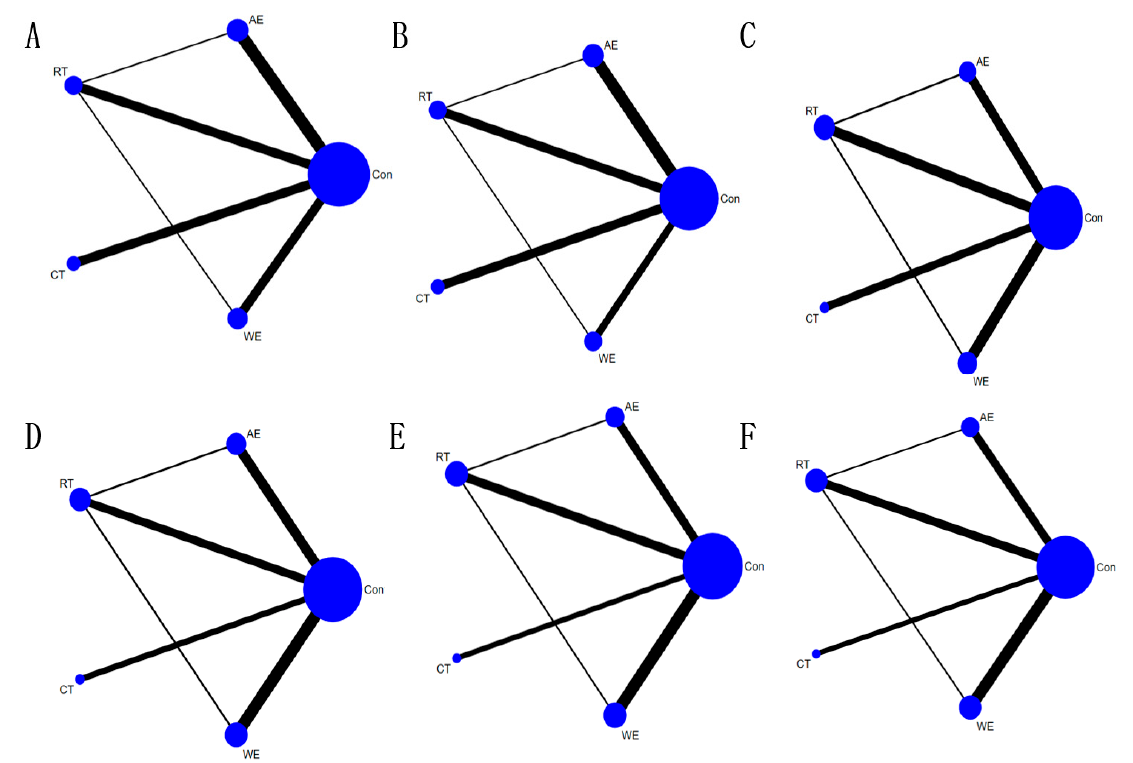
Figure 2. Evidence network diagram of network meta-analysis comparisons. Each node represents one exercise type. The lines between the dots indicate a direct comparison between the two modes of motion, with thicker lines for more studies and thinner lines for fewer studies. ( A ) Systolic blood pressure, ( B ) diastolic blood pressure, ( C ) total cholesterol, ( D ) triglycerides, ( E ) low-density lipoprotein cholesterol, ( F ) high-density lipoprotein cholesterol. AE, aerobic exercise; RT, resistance training; CT, combined training; WE, water exercise; CON, control